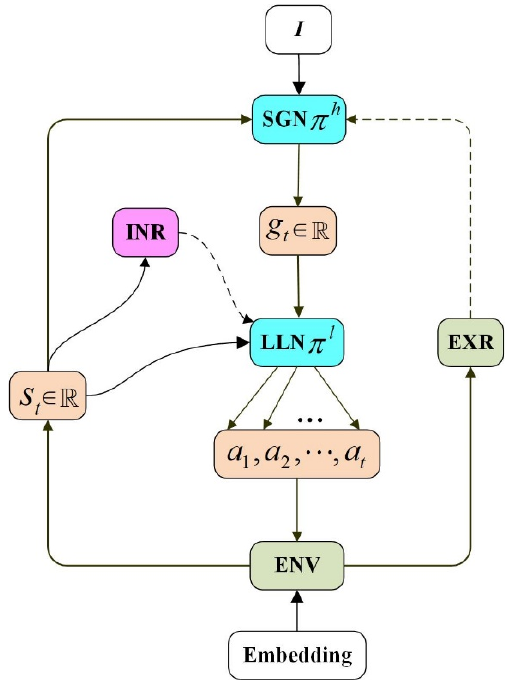
Figure 1. HRL-DCS network framework.